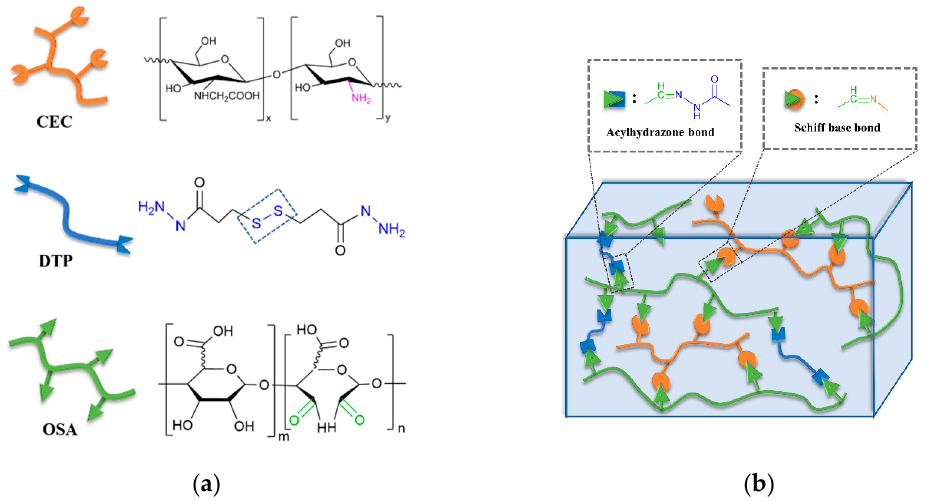
Figure 1. Synthesis of carboxymethyl chitosan (CMC)-oxidized alginate (OSA)-dithiopropionic acid dihydrazide (DTP) hydrogels. ( a ) Chemical illustrations and structures of CMC, DTP, and OSA; ( b ) Schematic illustration of the hydrogel cross-linking strategy.